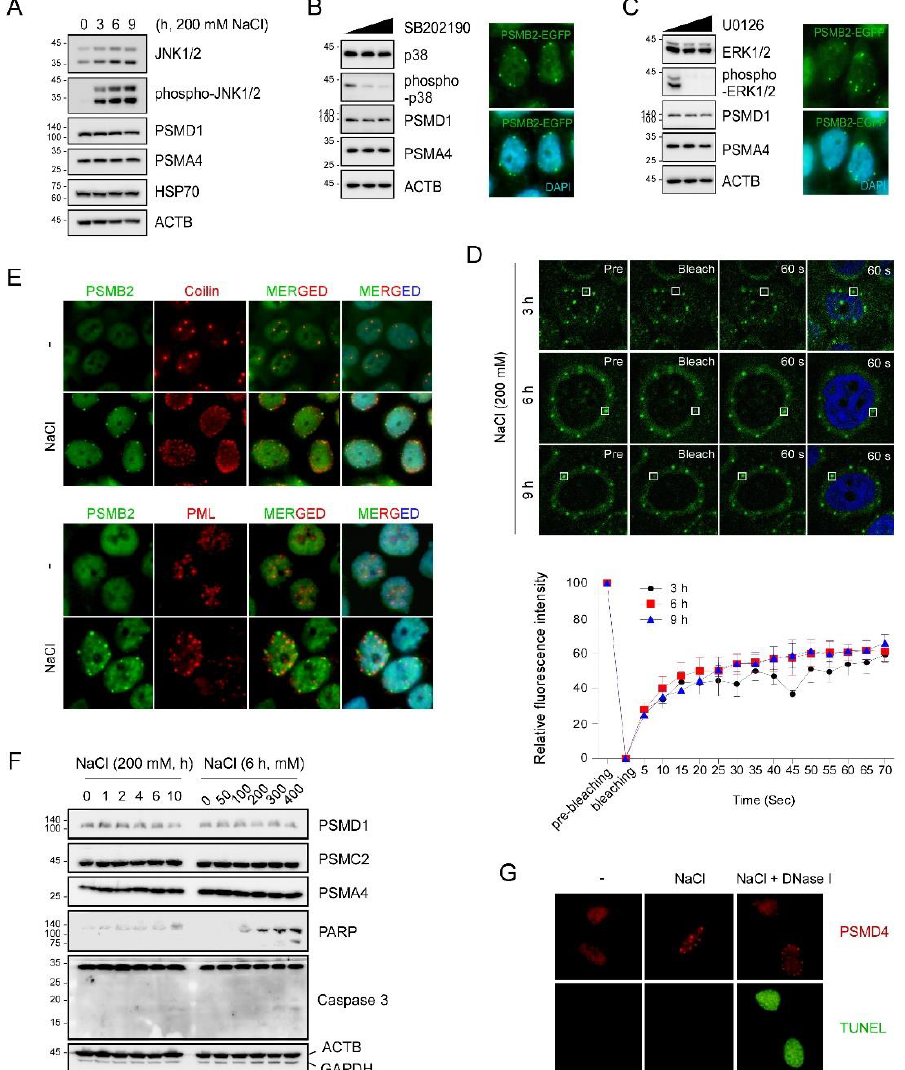
Figure 2. Hyperosmotic stress-induced nuclear puncta of proteasome foci are formed through liquid-liquid phase separation. ( A ) HCT116-PSMB2-EGFP cells were treated with 200 mM NaCl for the indicated time periods and their whole-cell extracts were subjected to SDS-PAGE followed by immunoblotting. ( B ) Cells under hyperosmotic stress were co-treated with 0, 25, and 50 µM of the p38 inhibitor SB202190 for 6 h. The whole cell extracts were subjected to SDS-PAGE/immunoblotting ( left ). Representative images are shown after treatment with 25 µM inhibitors ( right ). ( C ) As in B, except that the ERK inhibitor U0126 was used. ( D ) Top, fluorescence recovery after photobleaching of hyperosmosis (200 mM NaCl for 3, 6, or 9 h)-induced proteasomal foci in the cells. Shown are representative fluorescence images from pre-bleaching (Pre), bleaching, and recovery (60 s) stages on the region of interest (white square). Bottom, quantification of fluorescence recovery. ( E ) HCT116-PSMB2-EGFP cells under hyperosmotic stress were immunostained with coilin (a marker for Cajal bodies) and promyelocytic leukemia proteins (for PML bodies). ( F ) Apoptosis-related proteins were examined by immunoblotting. ( G ) Images of TUNEL-stained cells under hyperosmotic stress (200 mM NaCl for 6 h). For positive control, TUNEL staining was performed using DNAse I.